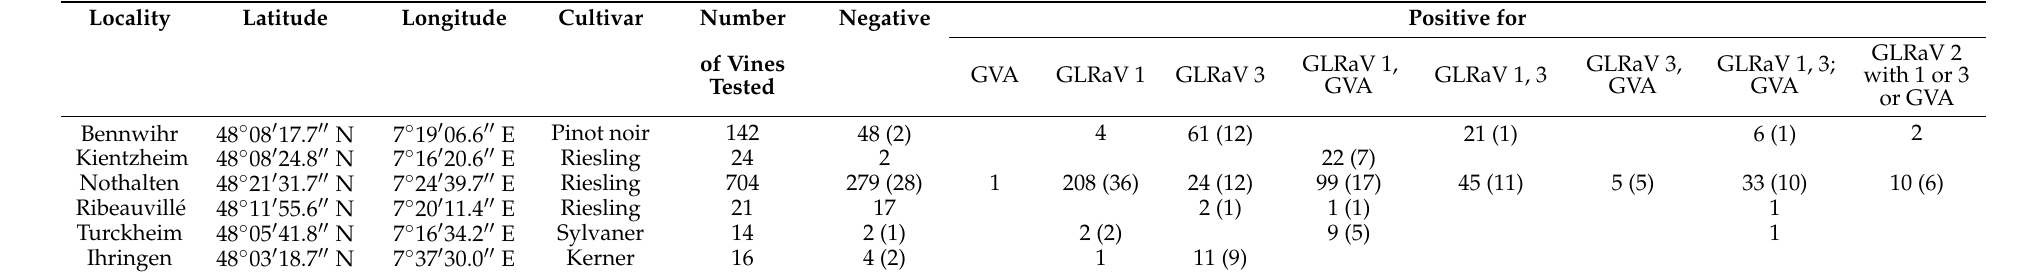
Table 1. Location of the vineyards sampled for Parthenolecanium corni populations and sanitary status of vines tested in ELISA for GLRaV 1, 2, 3 and GVA. The number of source vines used for transmission tests is indicated between brackets, with one or several replicates depending on the number of nymphs